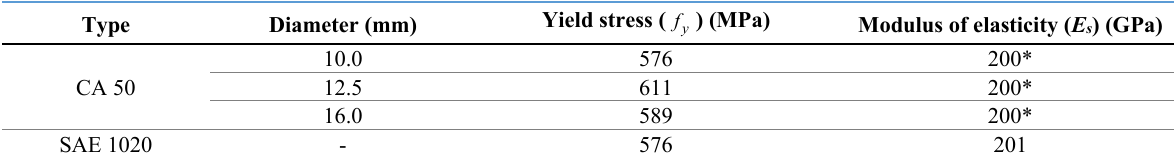
Table 3. Mechanical characteristics of